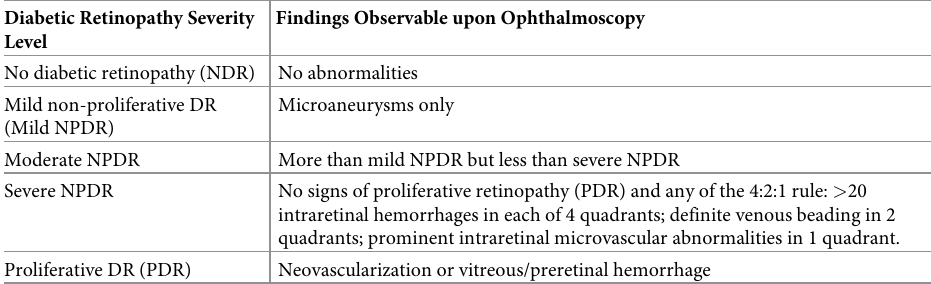
Table 1. The International Clinical Diabetic Retinopathy Severity Scale. Diabetic Retinopathy Severity